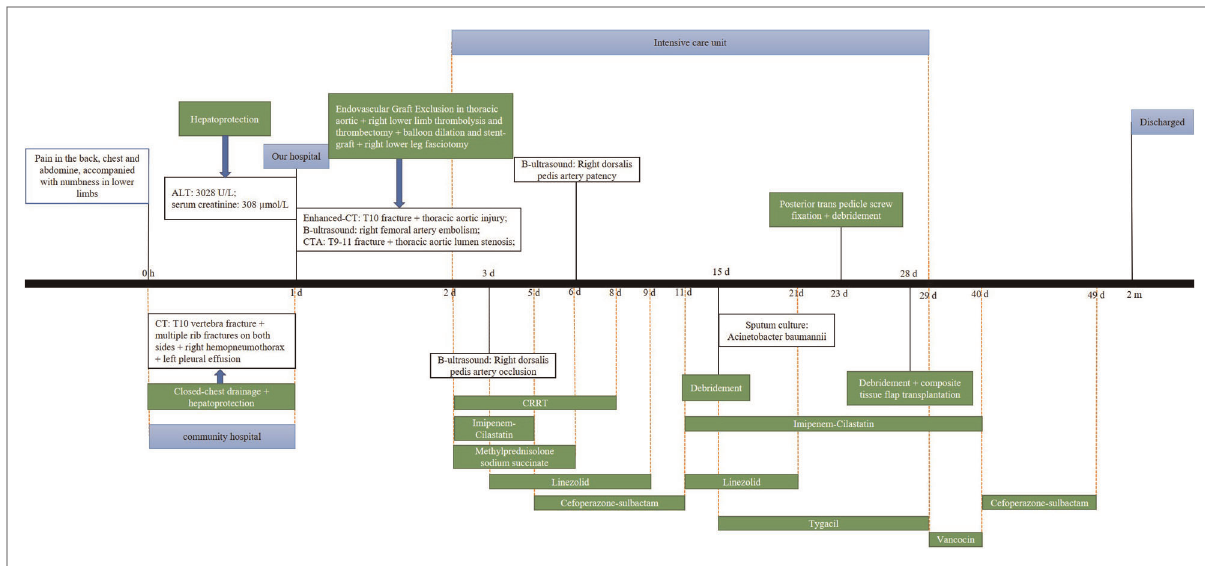
FIGURE 3 Timeline showing the diagnosis, treatment, and outcome in our patient. CT, computed tomography; CRRT, continuous renal replacement therapy; ALT, alanine aminotransferase; CTA, computed tomography angiography.